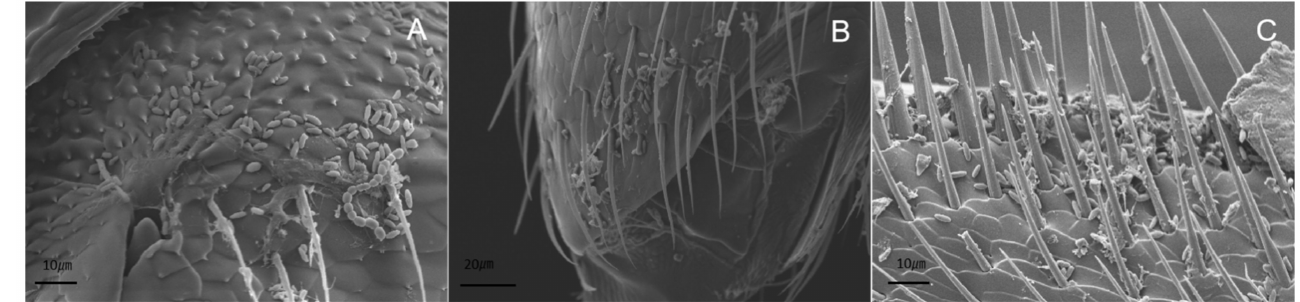
Figure 6. The attachment of conidia of I. javanica on the body surface after inoculation for 2 h. ( A ) Chest internode; ( B ) hind foot internode; ( C ) foot end.